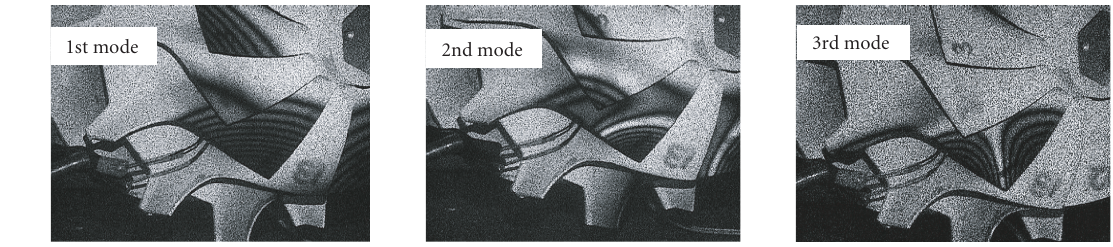
Figure 8: Blade bending modes measured by laser holography.